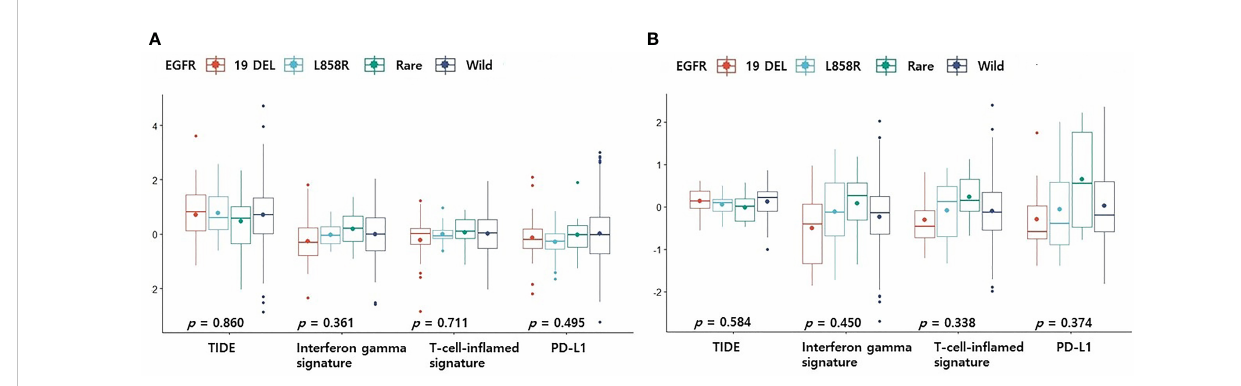
FIGURE 2 Differences in TIDE-related biomarkers according to EGFR mutational subtypes. Changes in levels of TIDE-related biomarkers according to EGFR mutational subtypes in pancancer dataset (A) and cptac dataset (B) . The small dot in the boxplot is the mean value. 19 DEL, exon 19